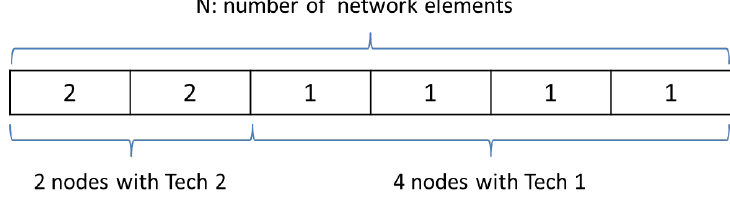
Figure 4. Chromosome coding for the fair technology distribution